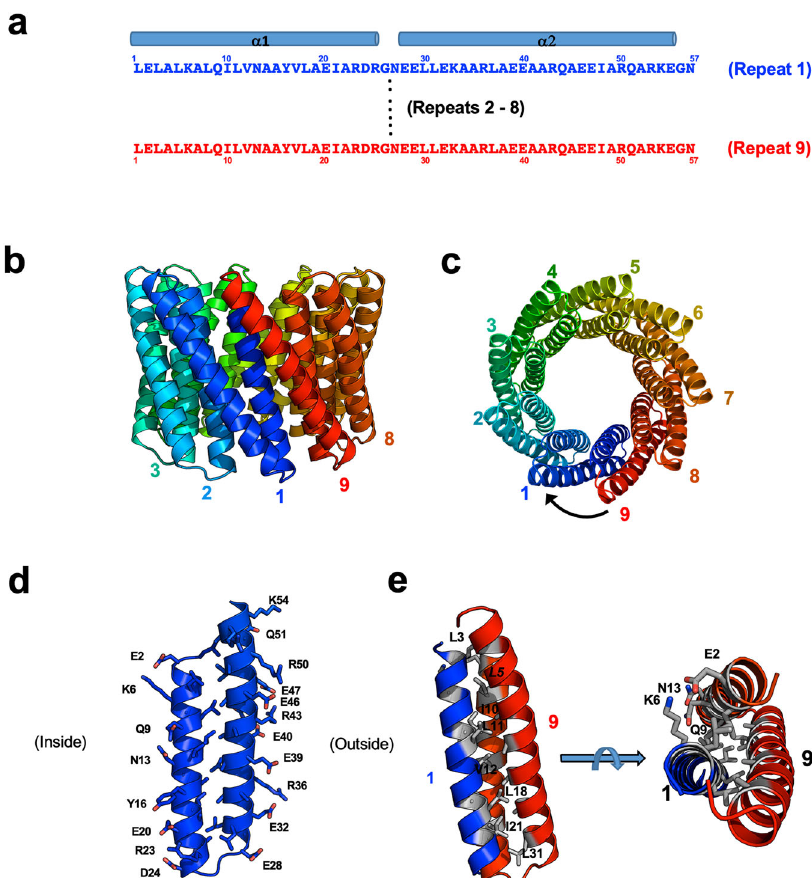
Fig. 1 Design of tcTRP9. a Sequence and secondary structure of individual repeats, which each consist of an anti-parallel two-helix bundle connected by short turns composed of ‘ GN ’ sequences. b , c Nine consecutive repeats (colored blue at the N-terminal repeat and progressing to red at the C-terminal repeat in all fi gure panels) form a closed cylindrical structure, with an exterior diameter of ~60 Å and an interior pore diameter of ~15 Å. d The structural composition of the two-helix bundle corresponding to each designed repeat places mostly charged side chains (largely glutamic acid and arginine residues) on the exterior of the particle, and a network of charged and hydrophilic residues (along with one aromatic tyrosine) on its interior surface. The interface between the two helices is largely composed of a series of leucine and alanine residues (not labeled). e The interface between individual repeats corresponds to a series of beta-branched (Ile and Val) and gamma-branched (Leu) hydrophobic residues that form a hydrophobic core between helices, fl anked by hydrophilic residues extending towards the interior and exterior of the tcTRP